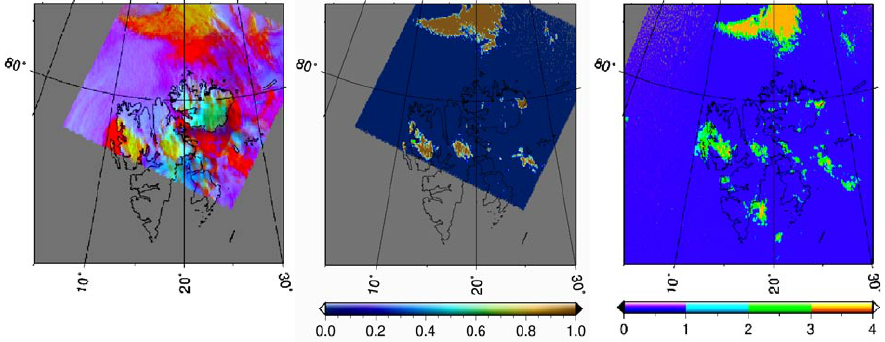
Fig. 5. The example of discussed cloud screening method: (a) the initial AATSR scene, 3 May 2006, Spitsbergen, 550nm; (b) the probability Fig. 5 The example of discussed cloud screening method: a) the initial AATSR scene, 3 rd of 2 of clear atmosphere over snow – the result of the cloud screening over snow routine. May 2006, Spitsbergen, 550nm; b) the probability of clear atmosphere over snow – the result 3 of the cloud screening over snow routine. 4